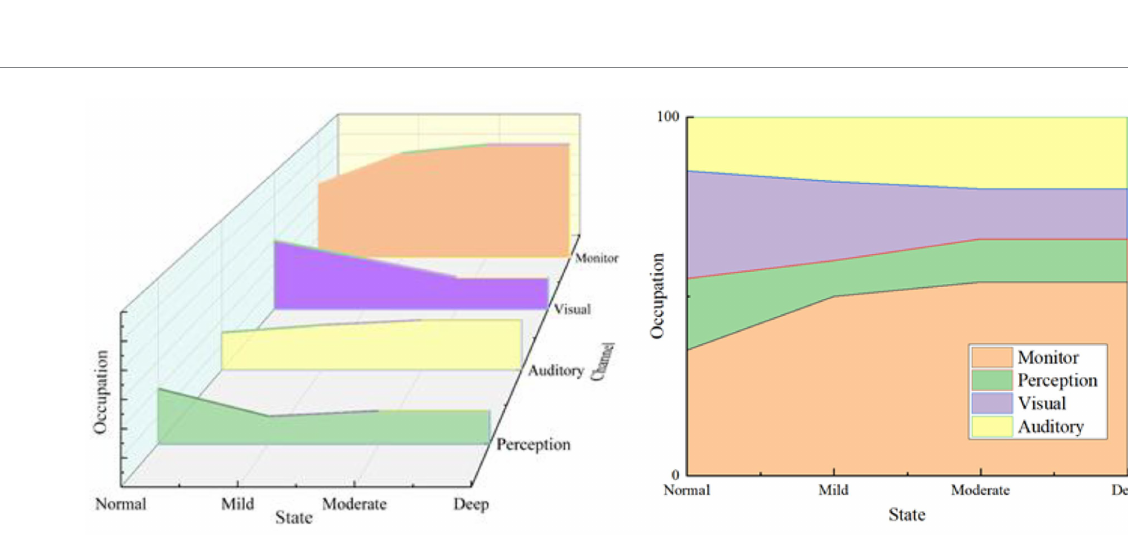
This result reflects that with the intensification of cognitive workload tasks, the driver’s brain monitoring ability continues to increase to control his behaviour for safe driving. However, due to the progress of cognitive tasks, with the deepening of the degree, the